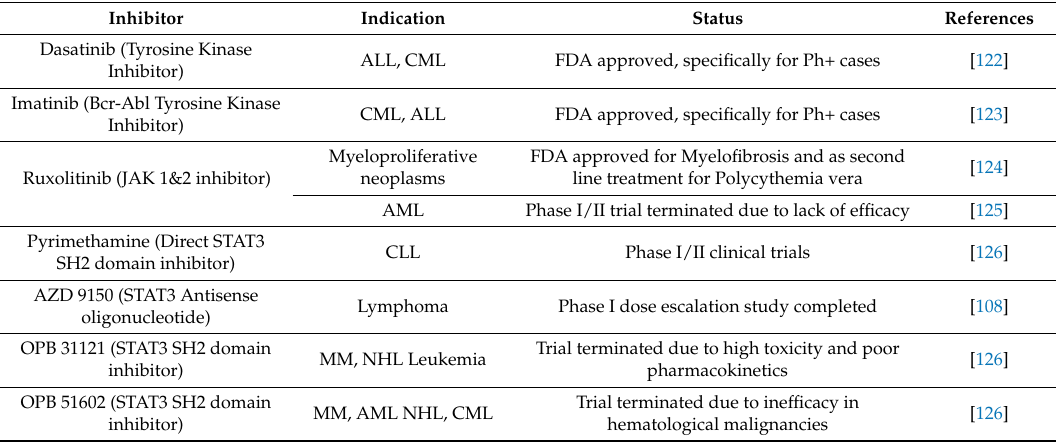
Table 2. Selective STAT3 inhibitors in clinical trials for hematological